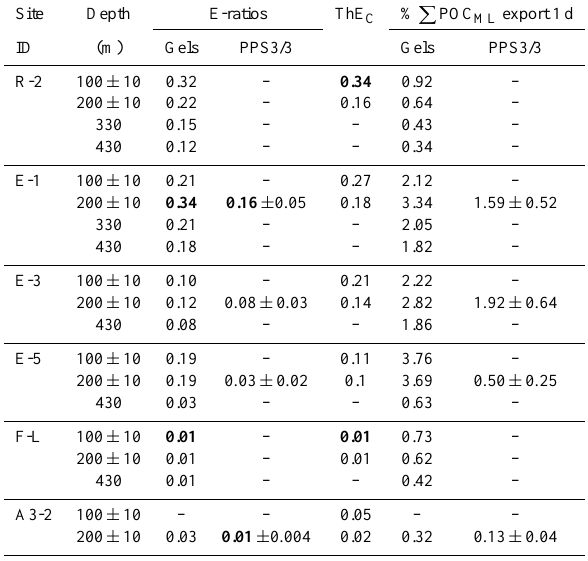
Table 5. Export efficiency at each site estimated from several meth- ods. Maximum and minimum export efficiencies are indicated in